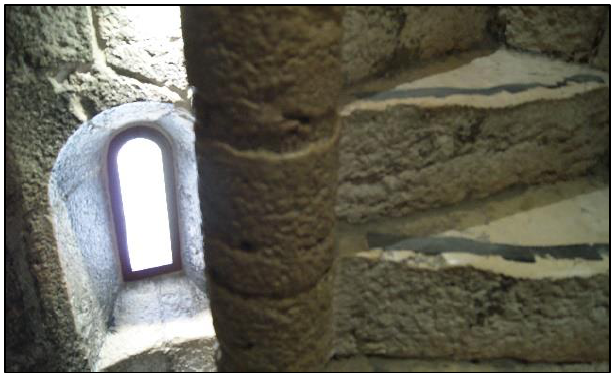
Figure 7. Spiral stairs of the Tower of Bel é